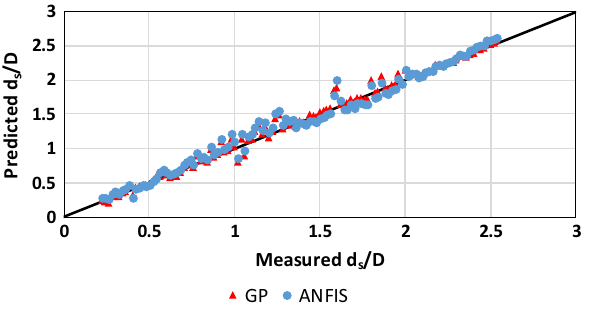
Fig. 2 ANFIS- and GP-predicted values of d ues for training sets